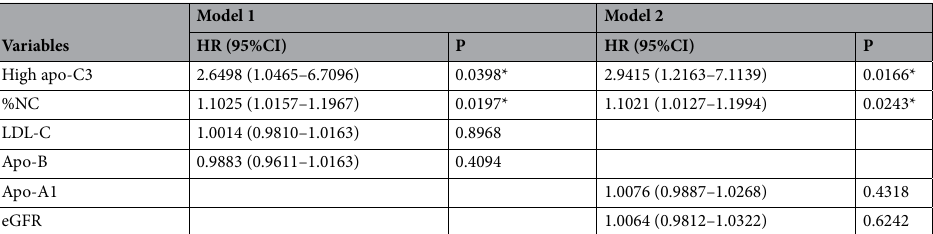
Table 5. Multivariate Cox hazards analyses of predictors of 4-year MACEs, adjusted for major confounders. MACE Major cardiovascular event; HR Hazard ratio; CI Confidence interval; apo-C3 Apolipoprotein C3; high apo-C3 Patients with apo-C3 > 8.5 mg/dL; %NC percentage of the plaque volume that is a necrotic core; LDL-C low-density lipoprotein cholesterol; eGFR estimated glomerular filtration rate. * P < 0.05.